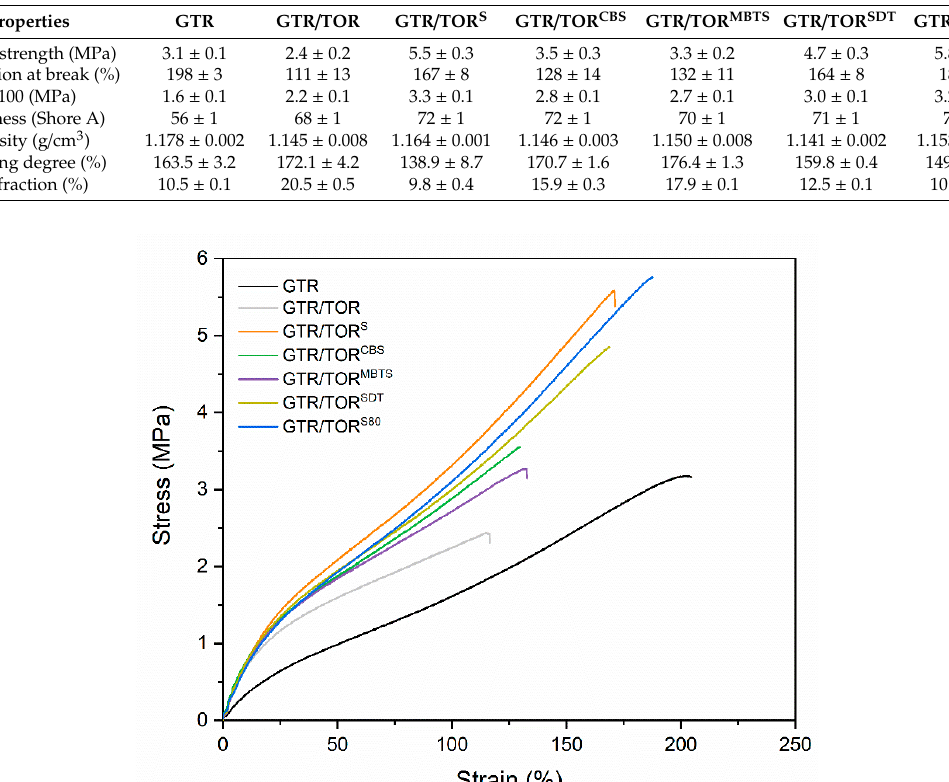
Figure 4. Stress–strain curves of the studied samples.